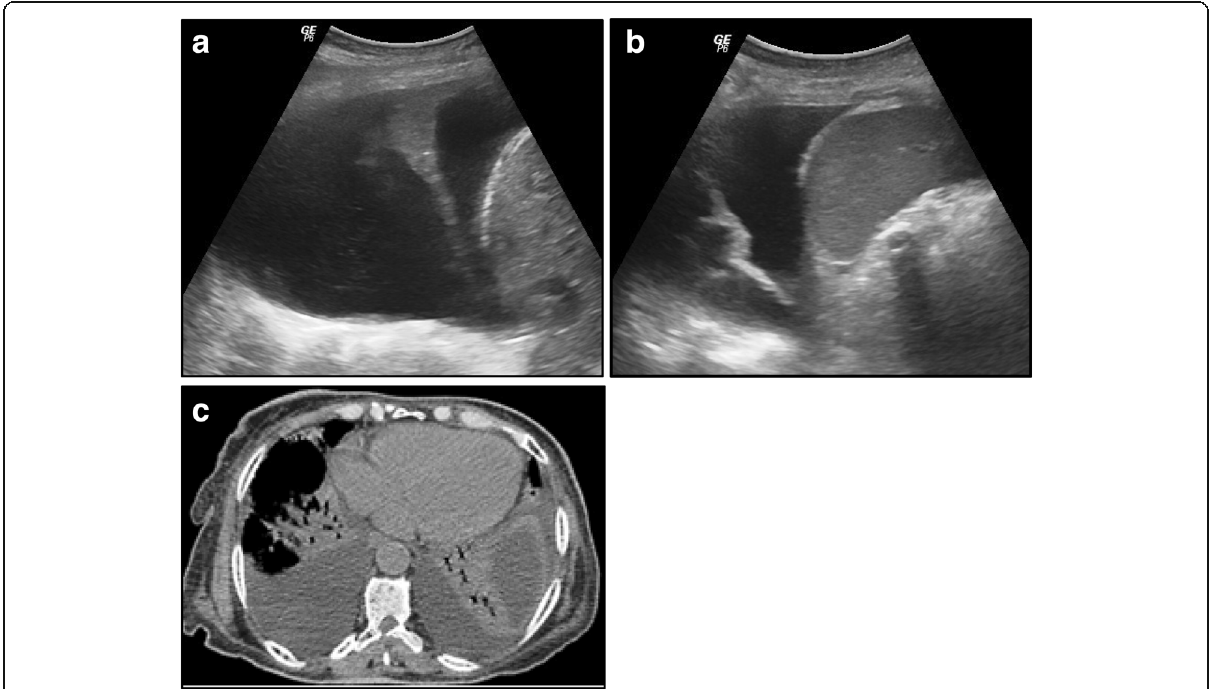
Fig. 1 US images show moderate right ( a ) and mild left ( b ) anechoic pleural effusion with underlying collapsed lung parenchyma. No evidence of pleural nodularity. c CT of the same patient revealed bilateral free pleural effusion with underlying compression collapse. Cytological examination of the pleural fluid revealed transudate